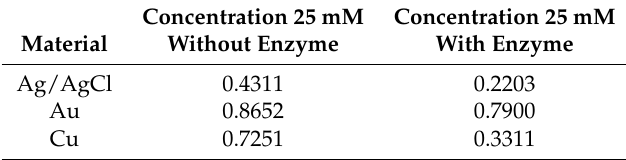
Table 8. Normality test— p -values for concentration of 25 mM.